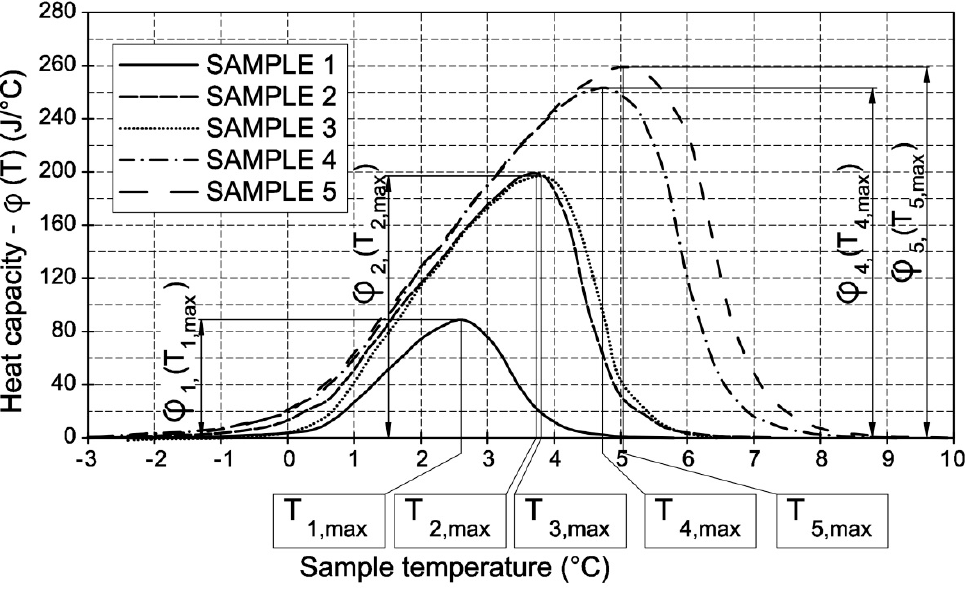
Figure 1. Plots of thermal capacity di ff erence among di ff erential scanning calorimetry (DSC) measurement targets for five